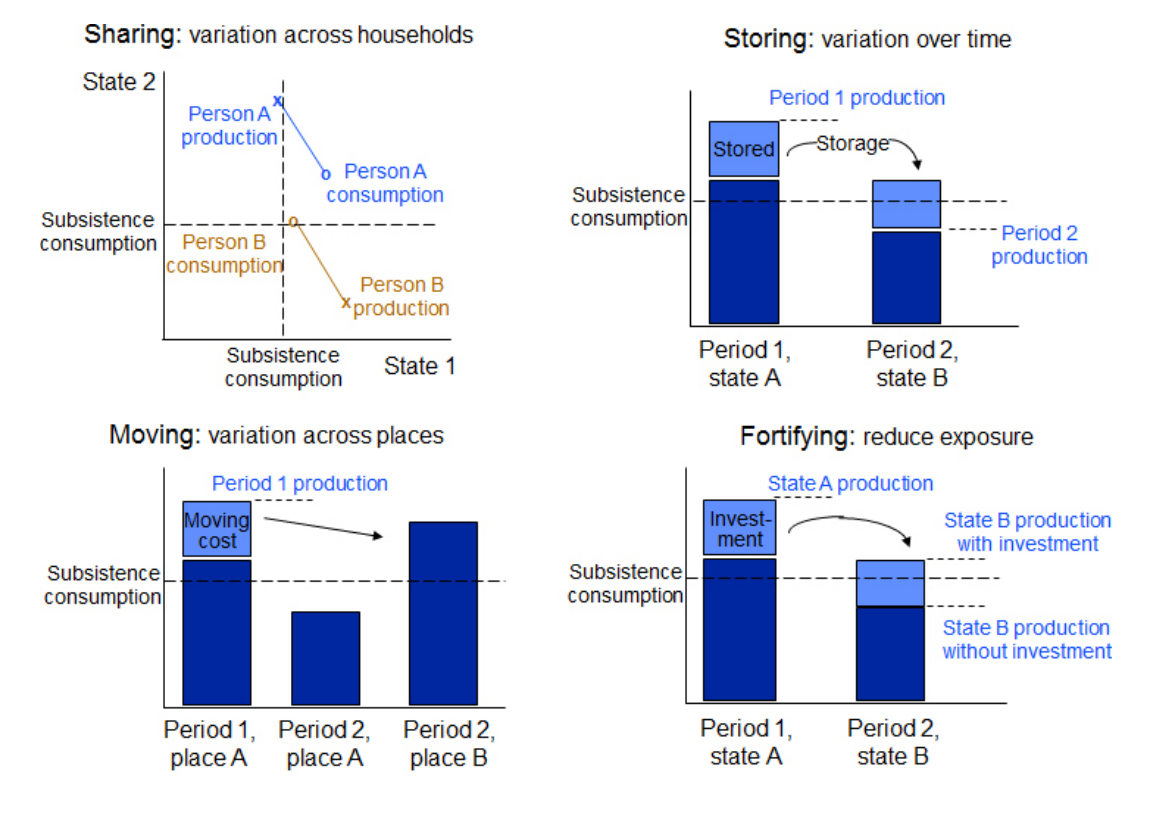
Fig. 2. Patterns of environmental uncertainty in a social–ecological system, along with associated mitigation